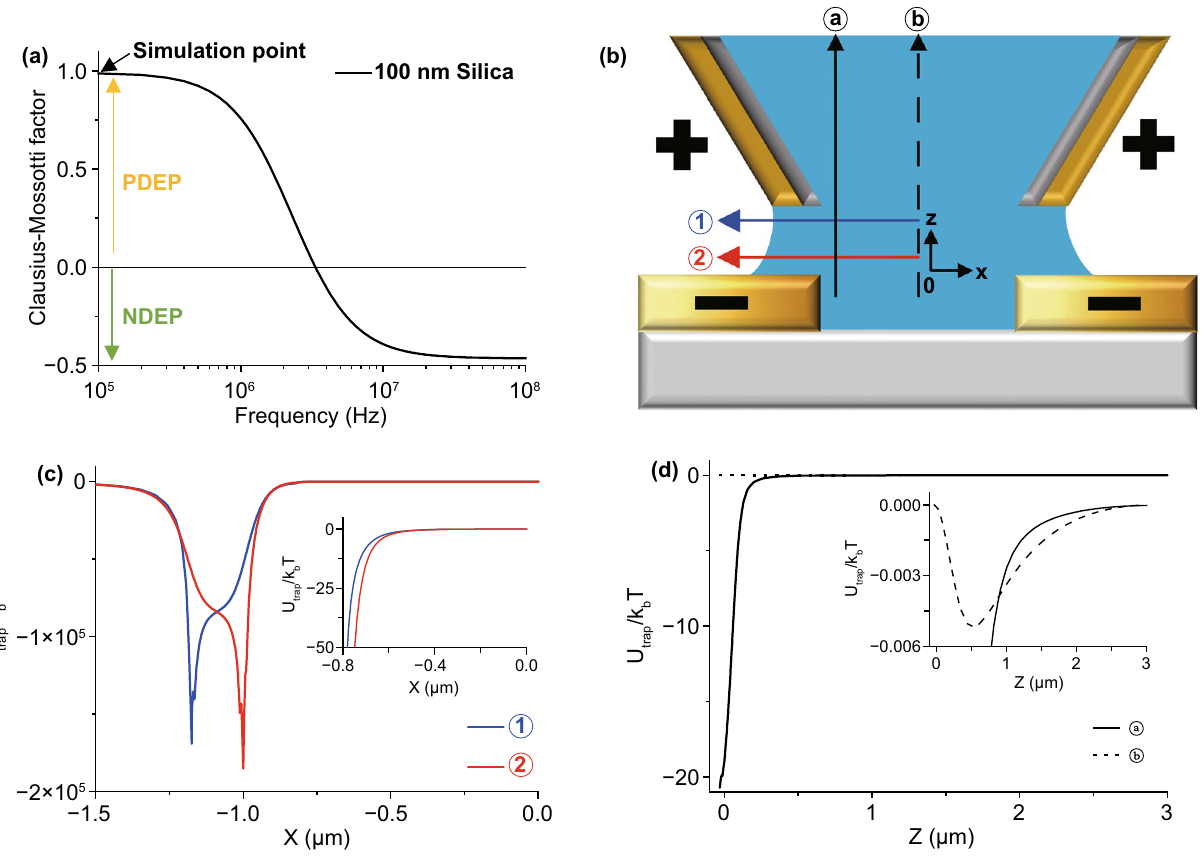
Fig. 2 a An example graph of Clausius–Mossotti factor ( f CM ) of 100 nm diameter silica nanoparticles. The sign of f CM determines PDEP or NDEP. The critical frequency of the sign is almost 3 MHz in this case. b Schematic diagram of the experiment with arrows for the X- and Z-directions. The phase of electrodes is determined by the simulation in Fig. S1. c Simulation graph of PDEP ( f CM = 1.0) trap energy vs. Brownian motion along the X-axis. V peak = 1.0 V, 15 MHz frequency of AC voltage, 100 nm diameter of the particle, 2.0 µm gap size, and 2.35 µm outer diameter of the pipette with a 0.7 R inner ∕ R outer ratio. The trap energy rapidly increases around the edge of electrodes near the outer diameter of the pipette at ① (±1.175 µm) and substrate at ② (±1.0 µm), so the particles affected by the PDEP force are supposed to move to the edge of the electrodes. The inset image shows an expanded graph near the center; it shows the same direction for the PDEP force. The NDEP case shown in Fig. S3 and the particles affected by NDEP gather around the center near zero. d Simulation graph of the DEP trap energy vs. Brownian motion along the Z-axis with the same conditions as c . The particles affected by PDEP force are supposed to move downward at ⓐ but the particles affected by NDEP go upward. However, in the inset graph, the Brownian motion energy is much bigger than the z-direction DEP trap energy at ⓑ, so particles are not affected by the DEP force in the Z-direction except near